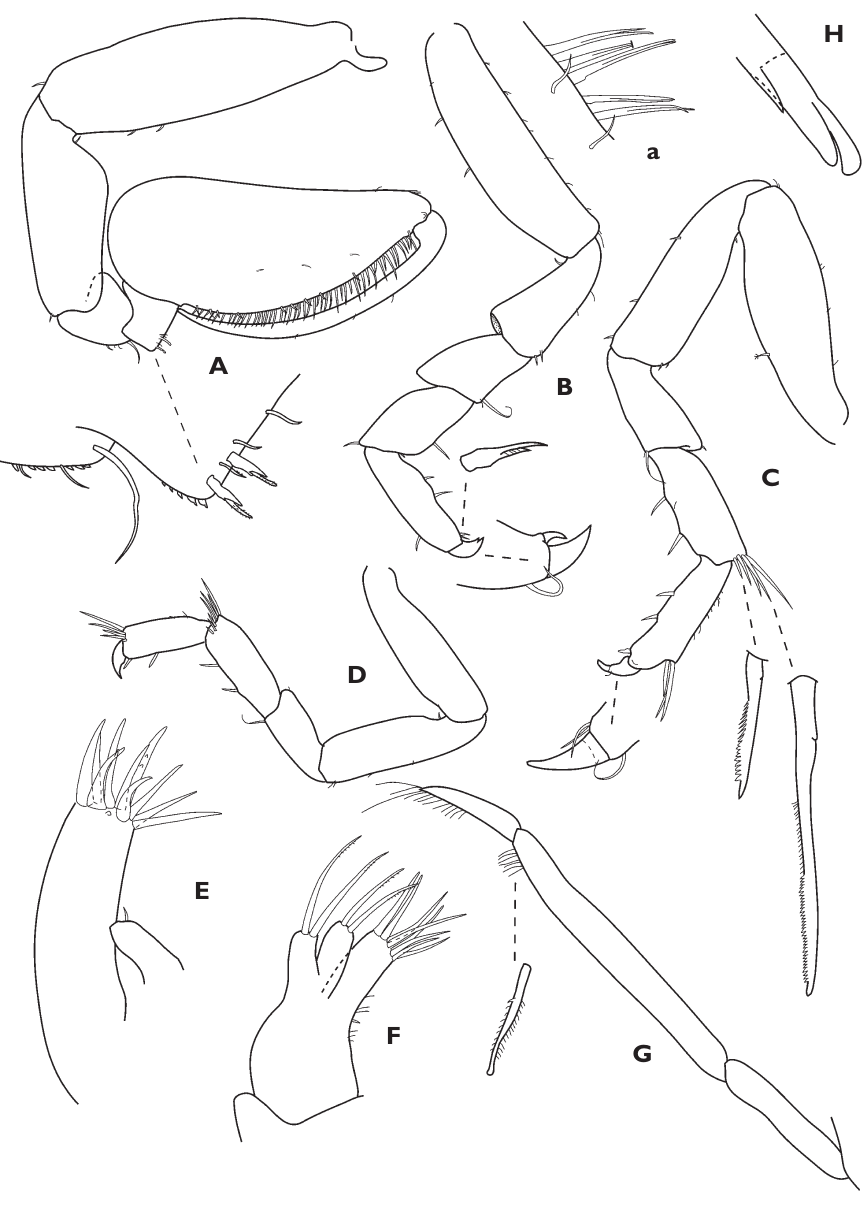
Figure 26. Th ysanoserolis orbicula sp. n. Holotype. A–D pereopods 1, 2, 6 and 7 respectively a detail of pereopod 1 propodal palm setae E maxillule F maxilla G mandible palp H pereopod 1, dactylus